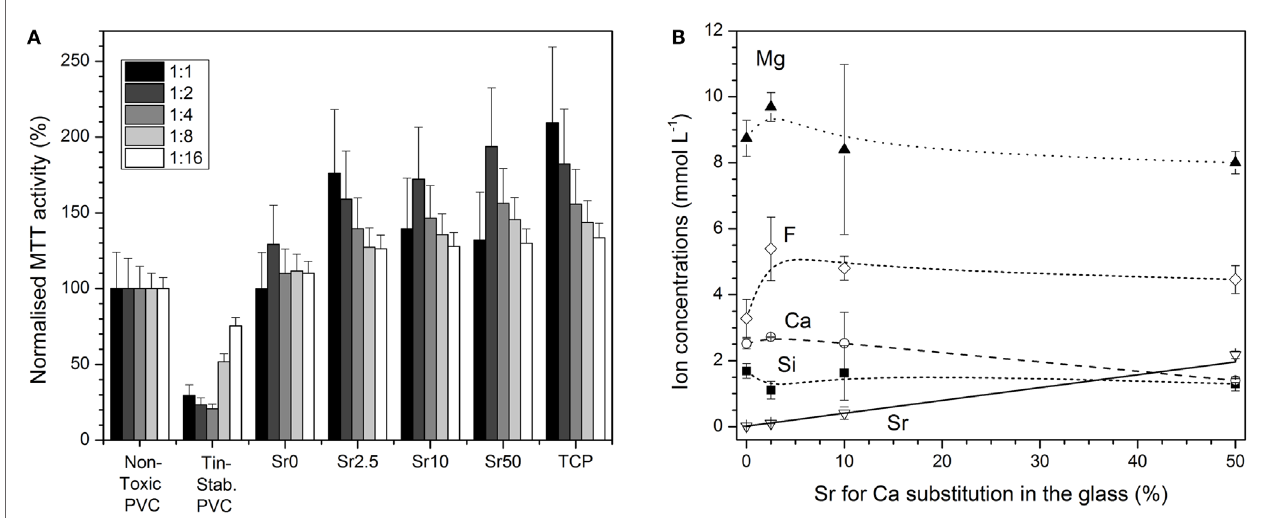
FigUre 7 | (a) Cytotoxicity assessment (ISO10993:5): Normalized MTT activity of MC3T3-E1 cells cultured for 24 h in conditioned medium (undiluted and diluted by factors 1:2 to 1:16) soaked with negative or positive control or cements made from glasses Sr0 to Sr50. (B) Concentrations of ions in cell culture medium vs. strontium for calcium substitution in the glass (solid line: linear regression; R 2 =